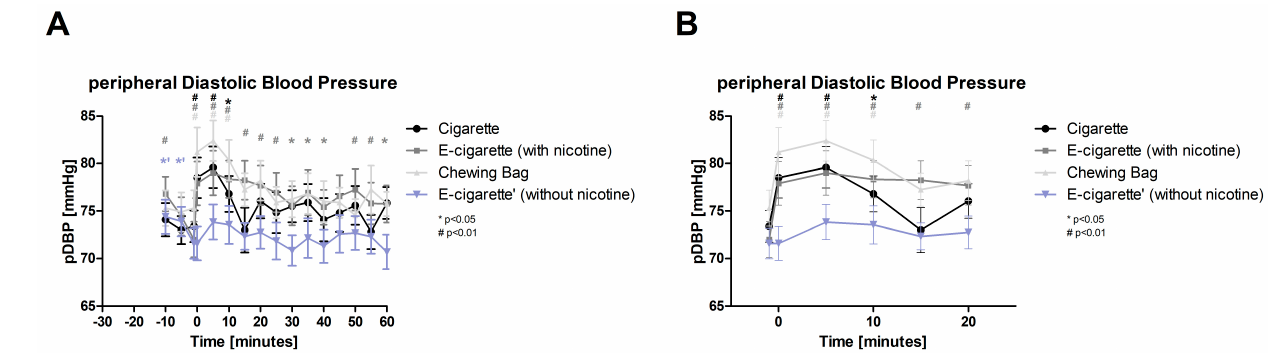
Figure 3. Peripheral diastolic blood pressure ( A ) total follow-up; ( B ) follow up of expected nicotine half-life. The figure displays the pDBP over time. At time 0 the intervention is undertaken, which causes the Cig, E-Cig (+) and Chewing bag to raise highly significant (# p < 0.01) over 15 min, Cig at 15 min after with p < 0.01.